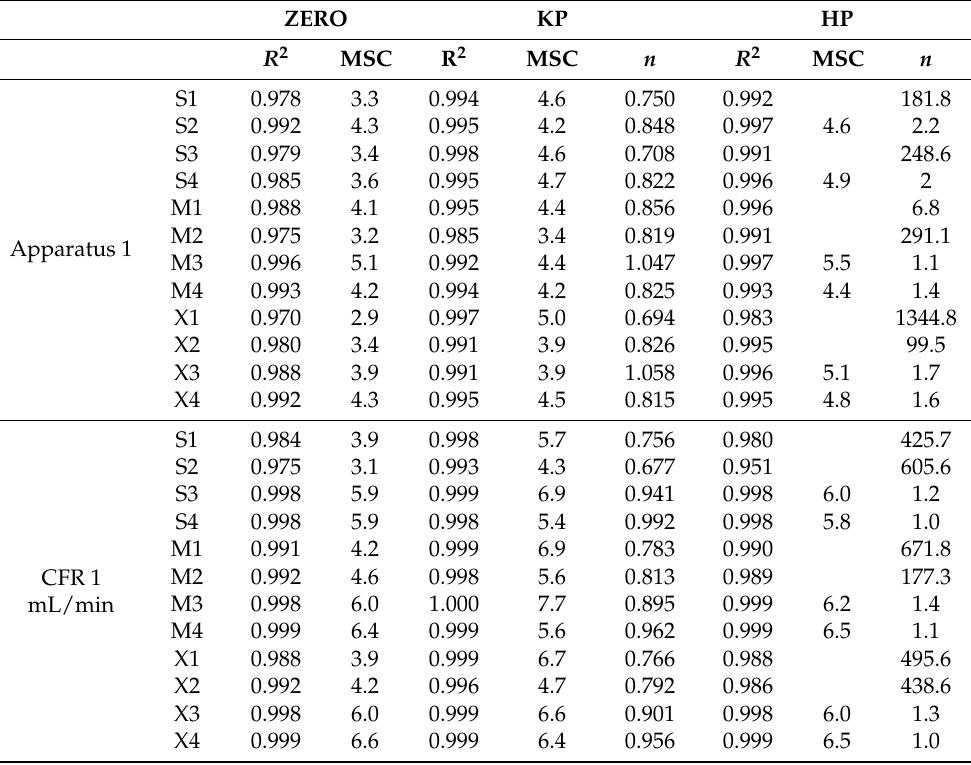
Table 5. Drug release kinetics using different fitting models for CHD formulation (Apparatus 1 dissolution) and CFR 1